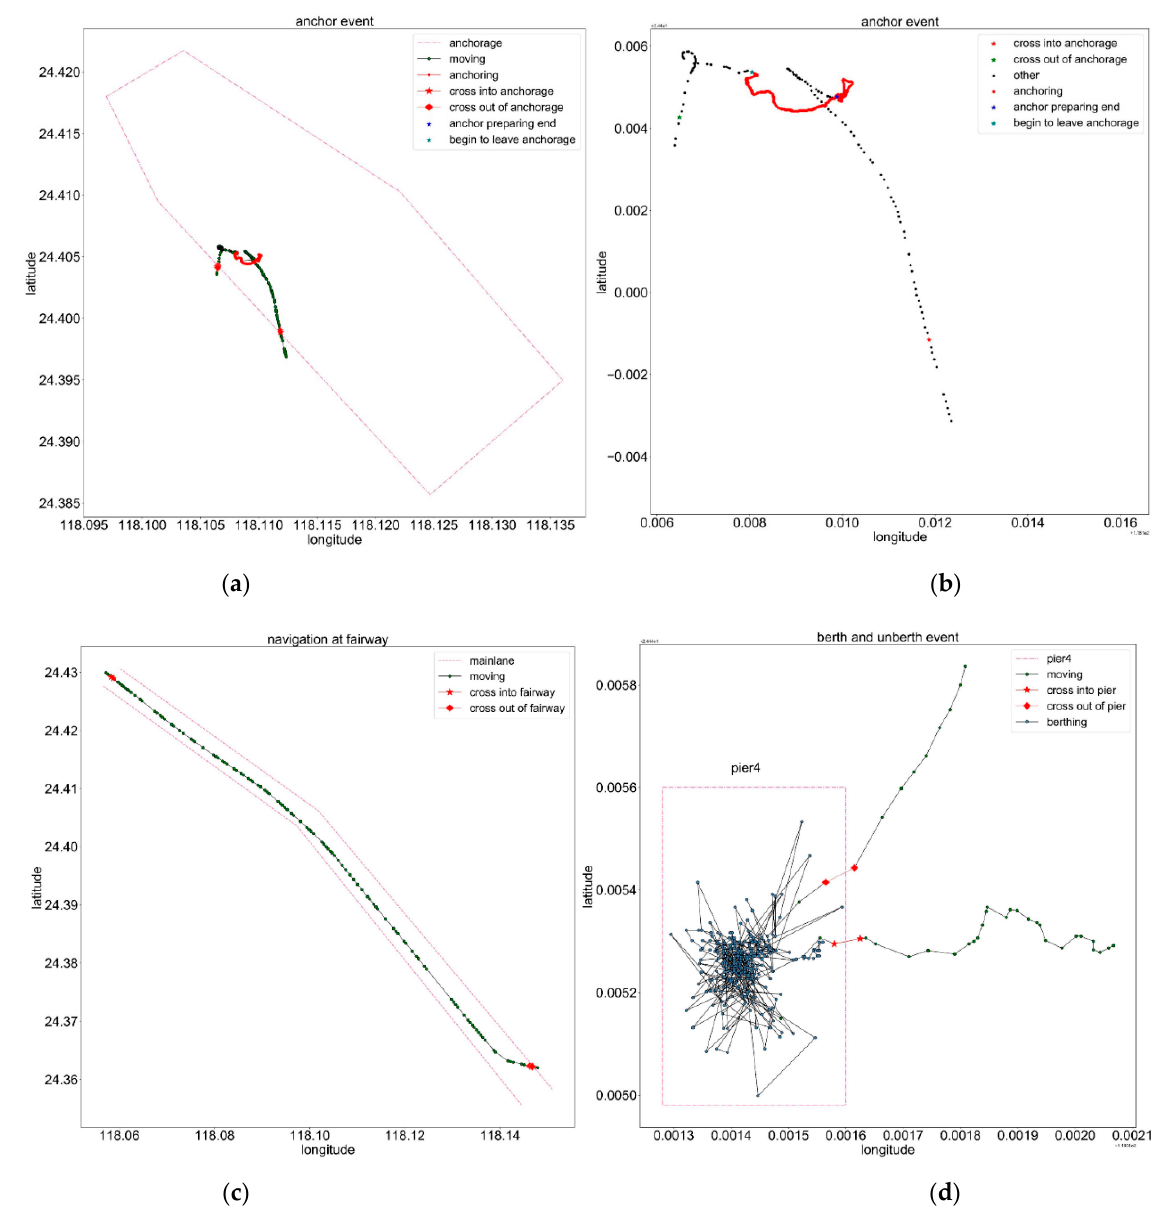
Figure 12. The visualization of the ship trajectories marked with corresponding behaviors. (Note: in order to facilitate the identification of ship behavior at the pier, a rectangular area of the pier in the port was extracted roughly from the ship berthing behaviors.). ( a ) Ship’s semantic behavior occurring at anchorage; ( b ) Zoomed-in view ship’s semantic behavior occurring at anchorage in ( a ); ( c ) Ship’s semantic behavior occurring at fairway; ( d ) Ship’s semantic behavior occurring at